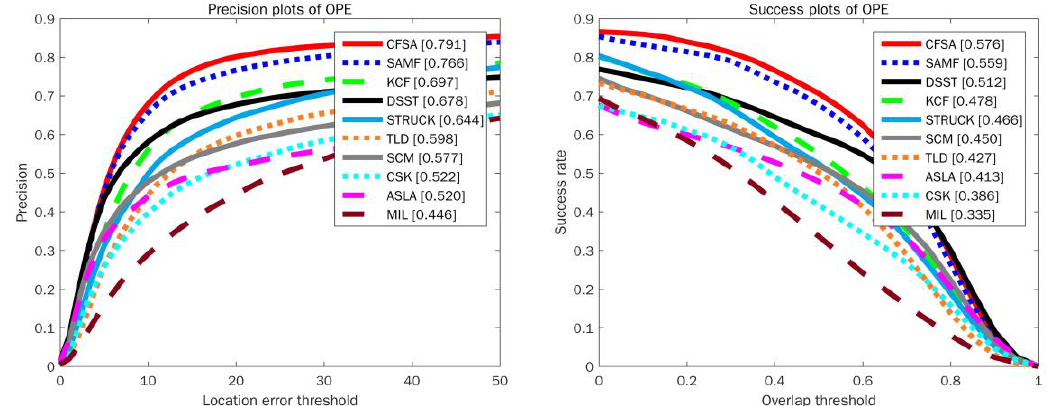
Figure 4. Precision and success plots over OTB-100 benchmark dataset using OPE.